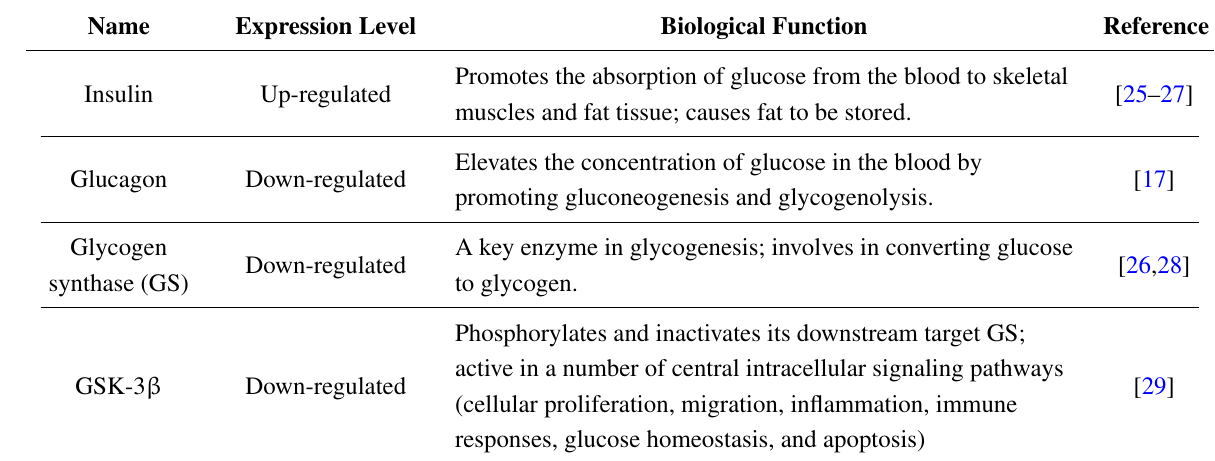
Table 1. The regulation of PASK in mammalian glucose